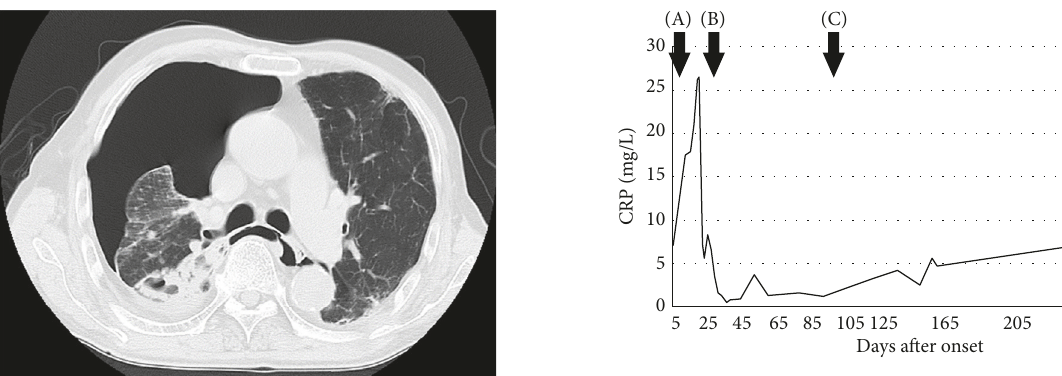
Figure 2: Clinical course and CRP concentration. (A) The first session of endobronchial Watanabe spigot application. (B) The second session of endobronchial Watanabe spigot application. (C) Cessation of air leakage. (D) Thoracic drain removal. CRP, C- reactive